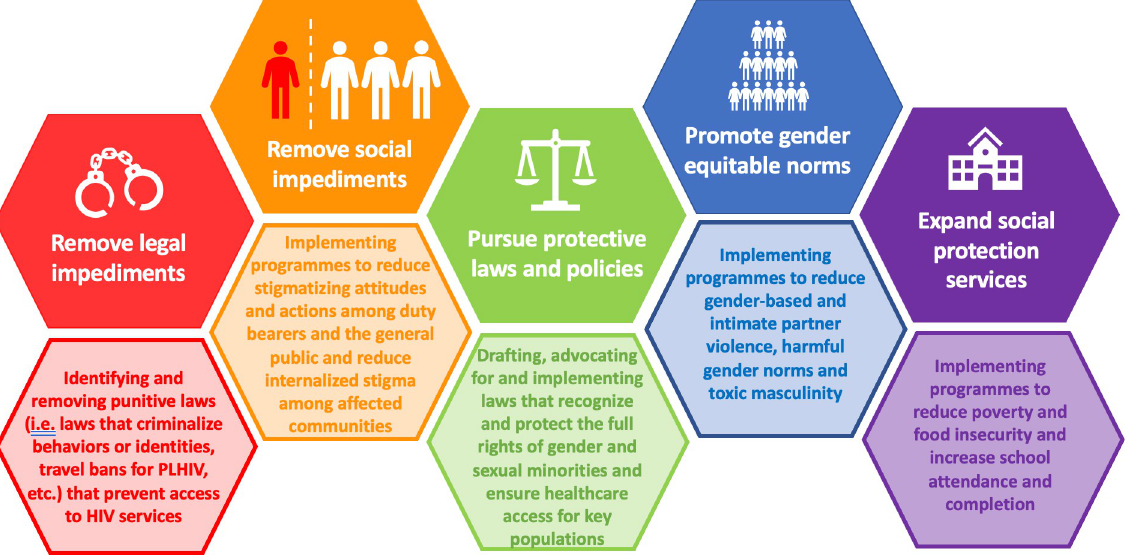
Fig 3. A societal enabling continuum to increase effectiveness HIV